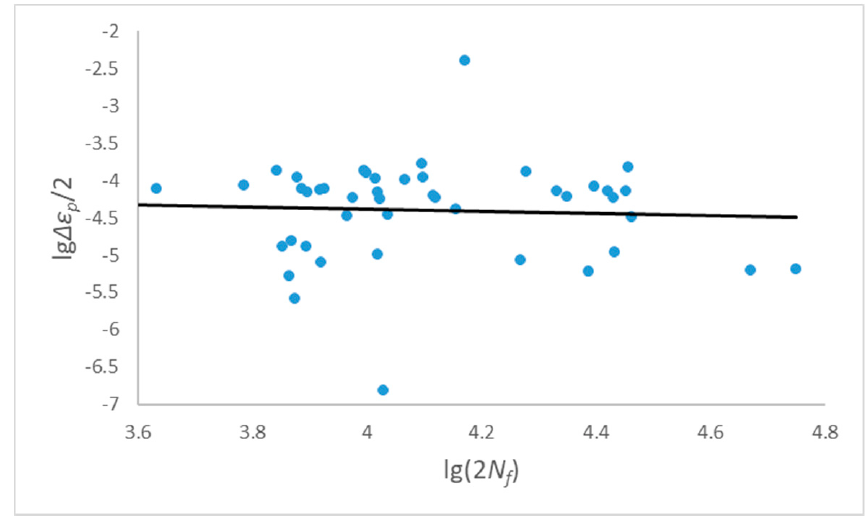
Figure 2. Fitting of plastic parameters when R = 0.05. Table 2. Parameter fitting results under 530 °C experimental conditions.